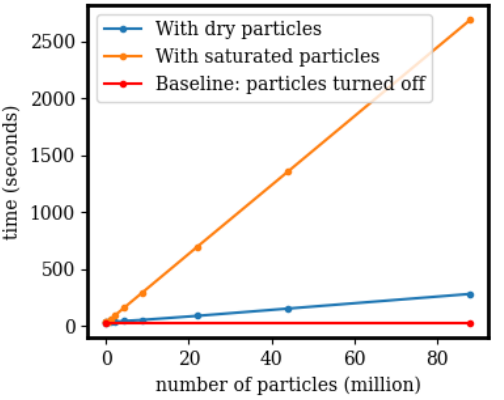
Figure 11. Performance effects of increasing the particle count using a Cray